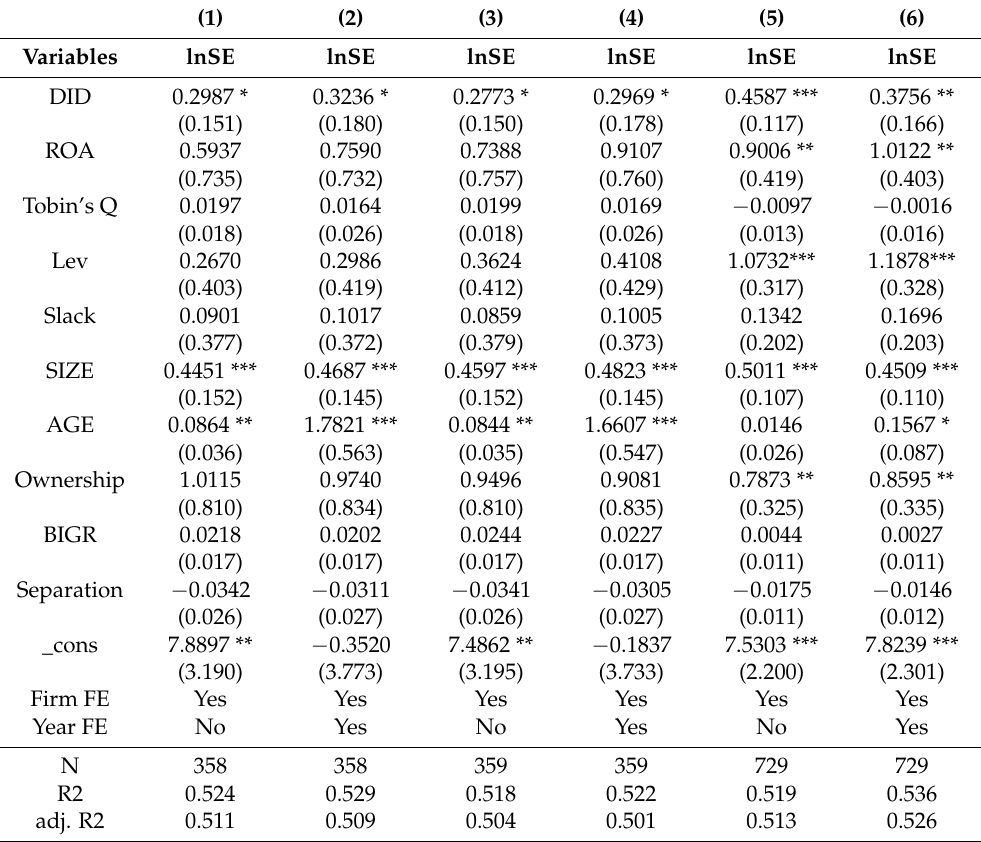
Table 9. Robust Test: